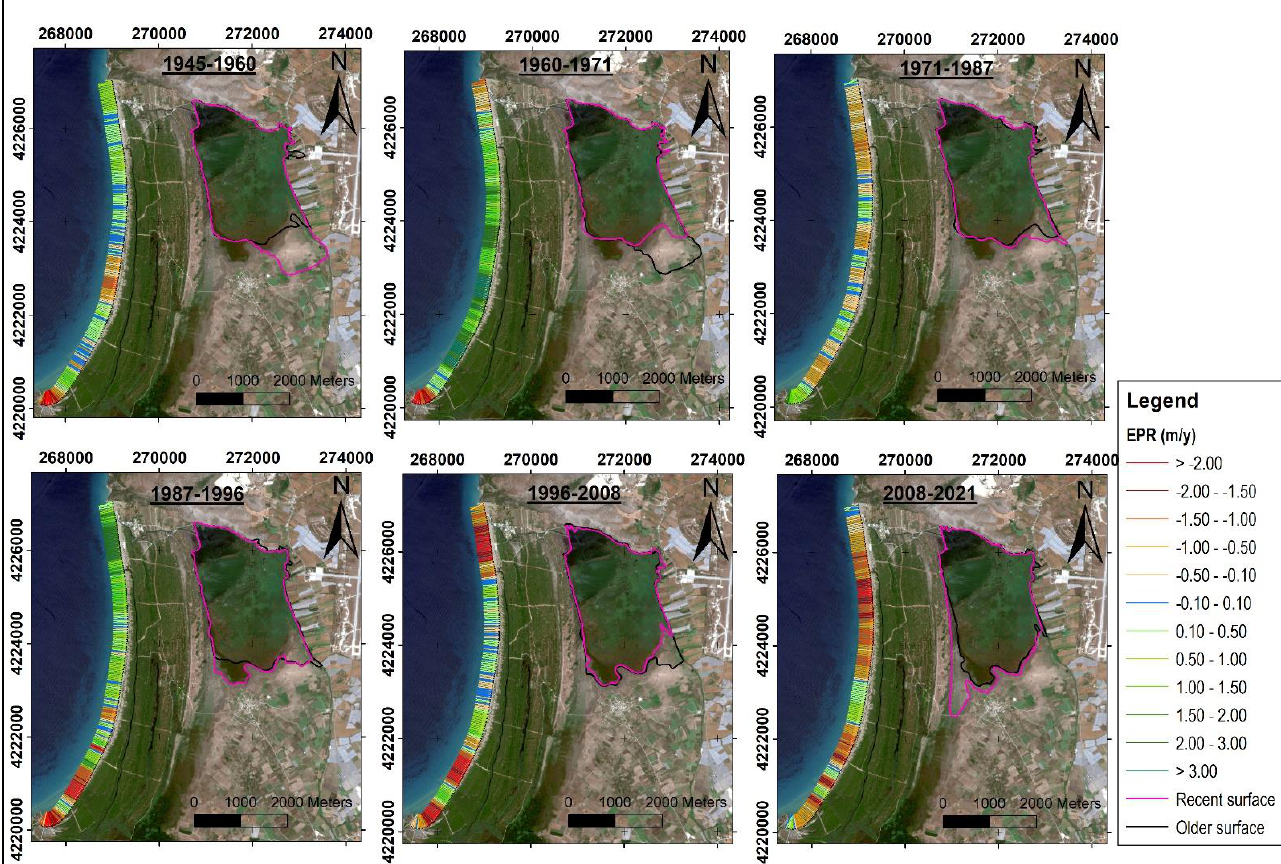
Figure 12. Diachronic shoreline changes using the EPR (m/yr) rates. Basemap of 2021. According to Figure 12 and Table 4, the general pattern of the coastal zone evolution was divided into five stages.